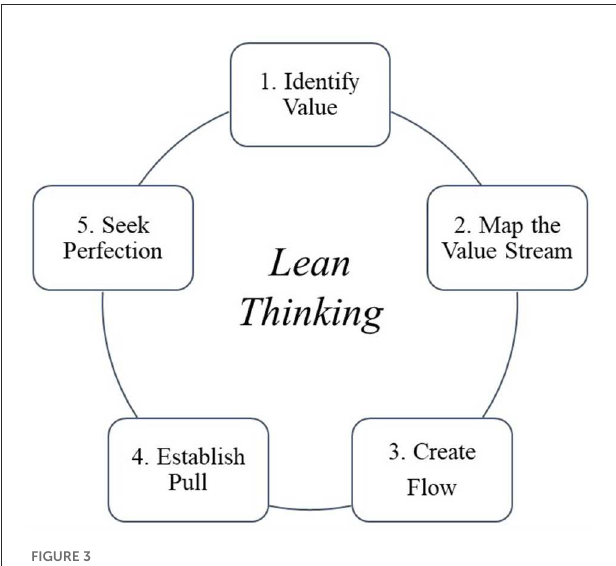
FIGURE3 The five steps of lean thinking